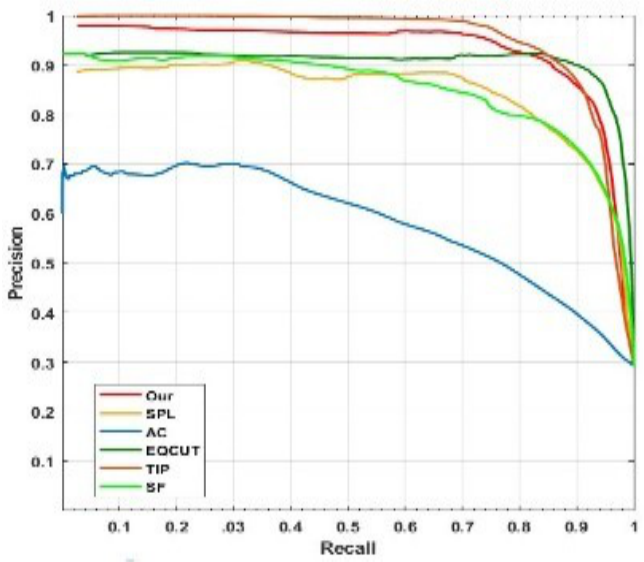
Table 2. Average Runtime (Images Per Second) for Five State-of-the-art Methods and Our Method.